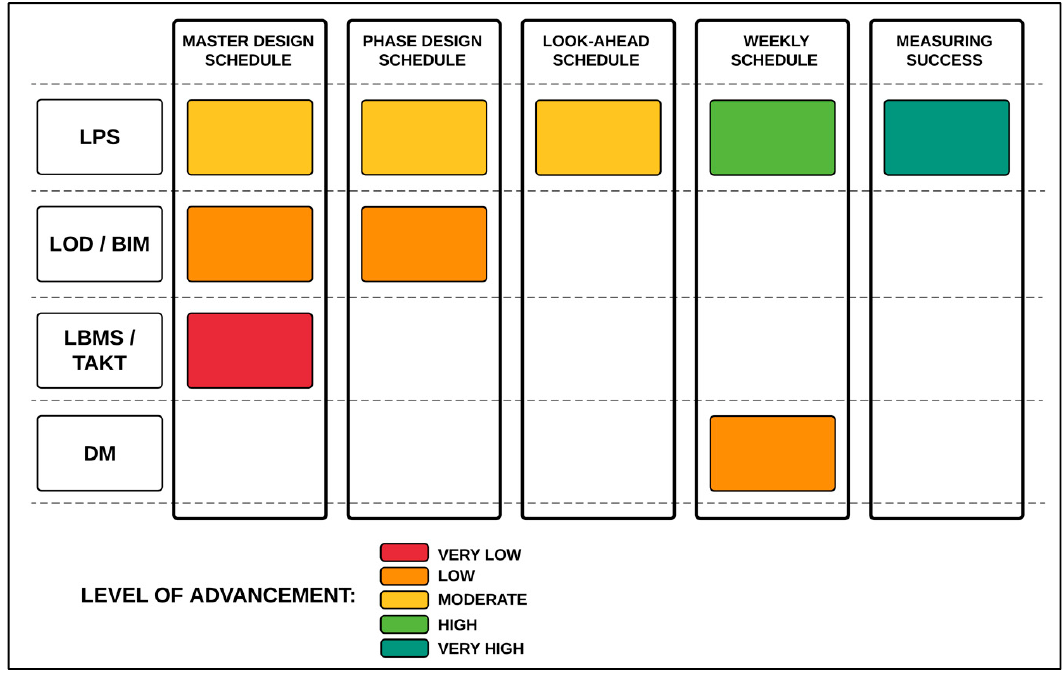
Figure 3. Case project’s experience of each of the Overall process components.